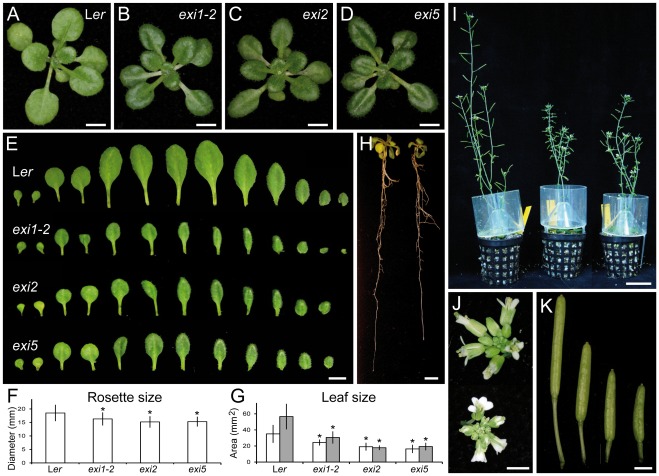
Morphology of the exi mutants.(A–D) Rosettes of the (A) Landsberg erecta (Ler) wild type and the (B) exi1-2, (C) exi2 and (D) exi5 mutants. (E) Series of Ler, exi1-2, exi2 and exi5 leaves. From left to right: two cotyledons and the first to tenth or eleventh leaves. Mutants display small, dark-green leaves of relatively normal shape. (F, G) (F) Rosette mean diameter and (G) lamina area from first-node (white bars) or third-node (grey bars) leaves. Asterisks indicate significant differences from the Ler control (P value<0.05; n = 11–20 individuals). (H) Root morphology in Ler (left) and exi5 (right) seedlings grown in near-vertically oriented plates. (I) From left to right, the reproductive morphology of Ler, exi1-2 and exi2 plants grown in pots. (J) Detail of Ler (up) and exi1-2 (down) inflorescences. (K) From left to right, siliques from Ler, exi1-2, exi2 and exi5 plants. Samples were taken (A–H) 21 and (I–K) 38 DAS. All the plants shown were homozygous for the indicated mutations (in italics). Scale bars indicate (A–E, H, J and K) 5 mm and (I) 3 cm.